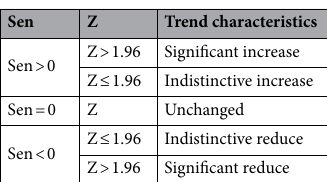
Table 5. Sen’s MK trend